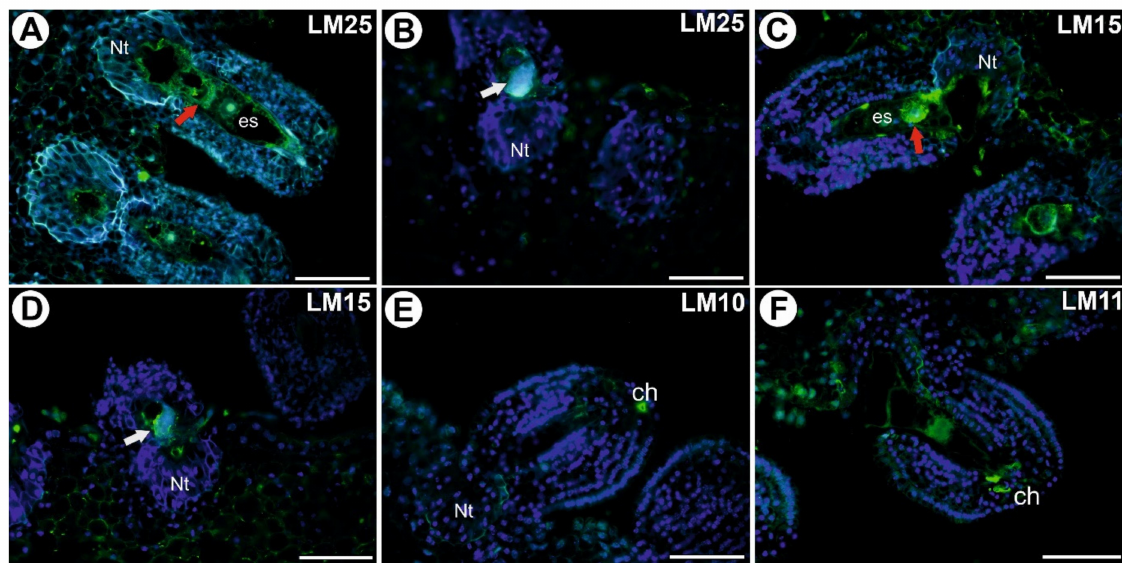
Figure 4. Xyloglucan detected in an ovule of Utricularia nelumbifolia after pollination and after fertilization (Antibodies–green fluorescence). ( A ) Xyloglucan (labeled with LM25) detected after pollination but before fertilization; embryo sac (es), egg cell (red arrow), placental nutritive tissue (Nt), bar 50 µ m. ( B ) Xyloglucan (labeled with LM25) detected after fertilization; synergid after it had been penetrated by the pollen tube (white arrow), placental nutritive tissue (Nt), bar 50 µ m. ( C ) Xyloglucan (labeled with LM15) detected after pollination but before fertilization; embryo sac (es), egg cell (red arrow), placental nutritive tissue (Nt), bar 50 µ m. ( D ) Xyloglucan (labeled with LM15) detected after fertilization; synergid after it had been penetrated by the pollen tube (white arrow), placental nutritive tissue (Nt), bar 50 µ m. ( E ) Xylan (labeled with LM10) detected after pollination but before fertilization; placental nutritive tissue (Nt); note the positive signal at the chalaza (ch), bar 50 µ m. ( F ) Xylan/arabinoxylan (labeled with LM11) detected after pollination but before fertilization; note the positive signal at the chalaza (ch), bar 50 µ